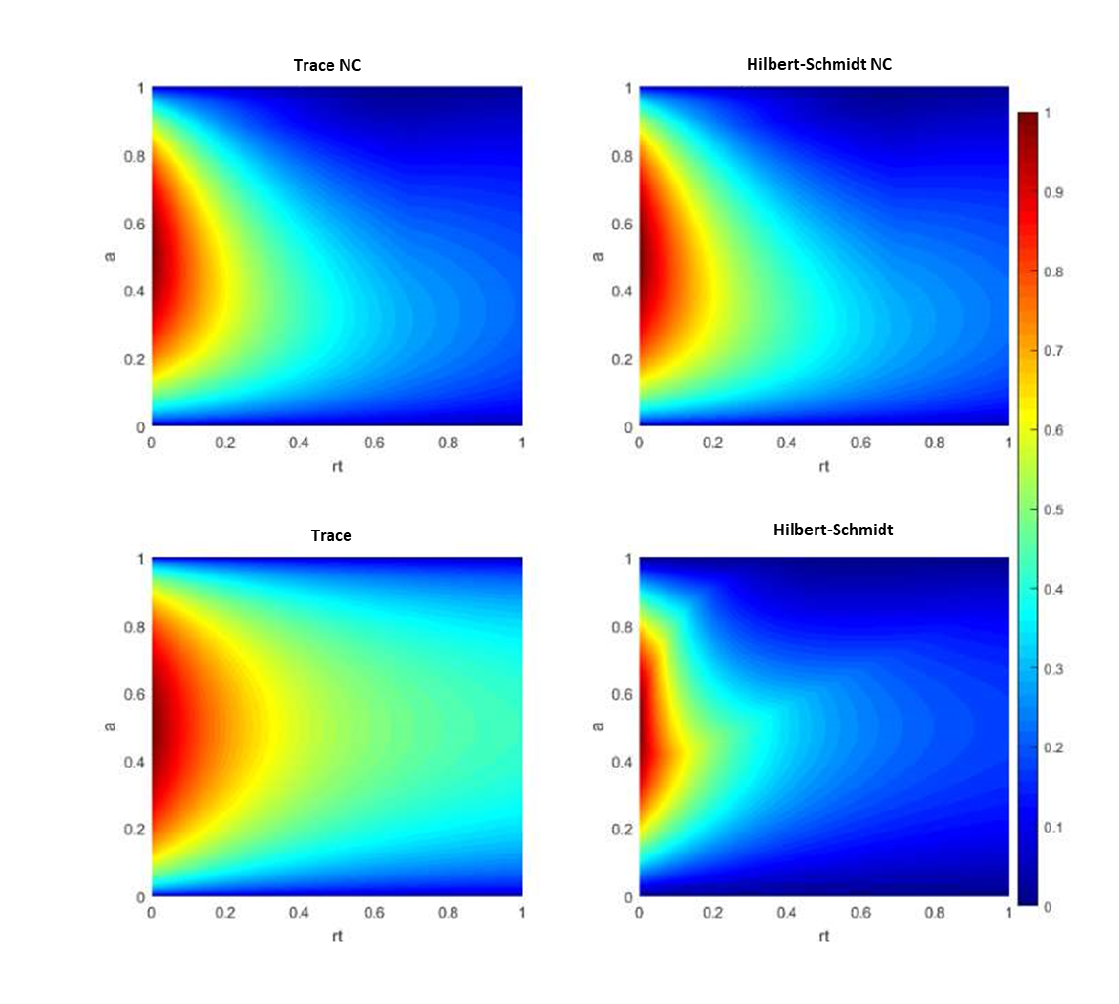
Figure 2. Change of the initial state | Ψ > with respect to γ t and α as the interatomic distance is ξ ij = 0. For this model, the trace distance discord is symmetrical about α = 0.5. Moreover, compared to the trace distance discord, we find that the non-commutativity measure of quantum discord and the Hilbert-Schmidt distance discord have more similar properties at different α values. On the other hand, the Hilbert-Schmidt distance discord will revive after α large enough. In this aspect, the non-commutativity measure of quantum discord are closer to the trace distance